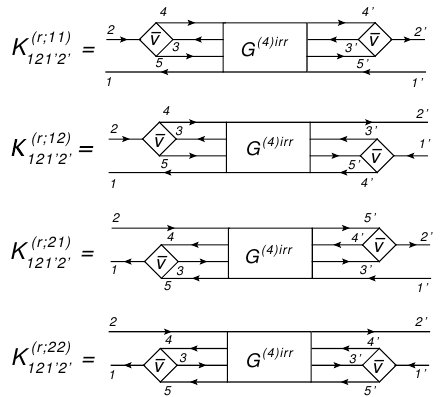
t (cid:29) ). ( t 12 , 1 (cid:29) 2 (cid:29) −